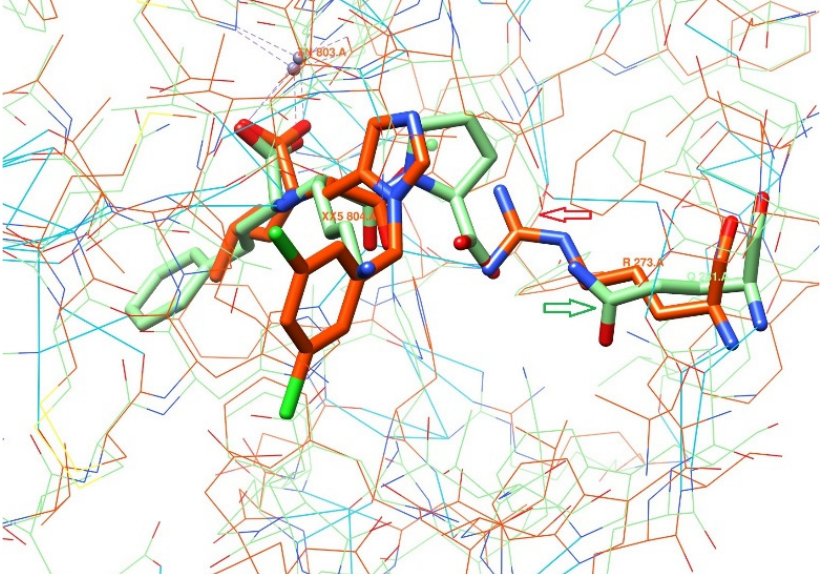
Figure 2. Comparison of ACE2 and ACE binding sites. In lime green—ACE with ligand lisinopril (PDB code: 1O86/LPR ), in orange—ACE2 with ligand ORE-1001 (PDB code: 1R4L/XX5 ), in blue— hydrogen-bonding contacts. Lime green and orange arrows are pointing at GLN281 and ARG273 in ACE and ACE2, respectively.